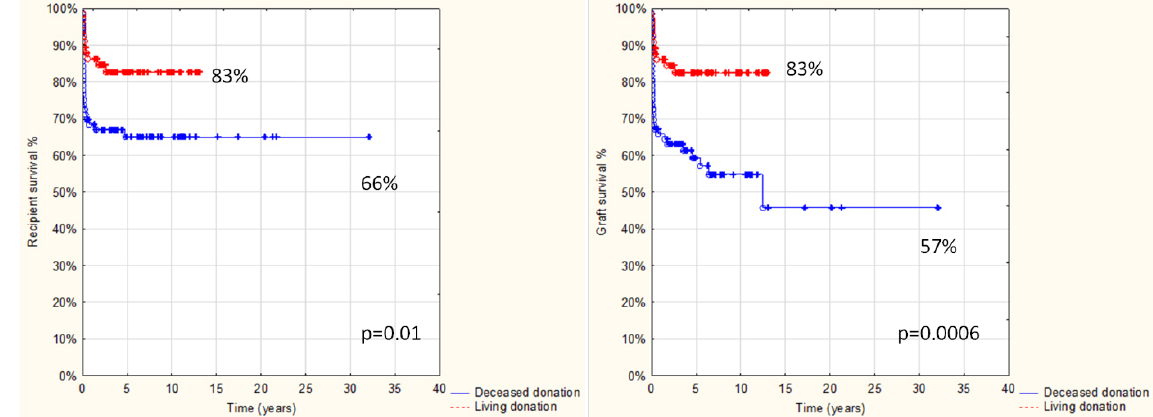
Figure 2. Patient and graft survival in relation to donor type in 142 pts after AB0i LT ( p < 0.05).